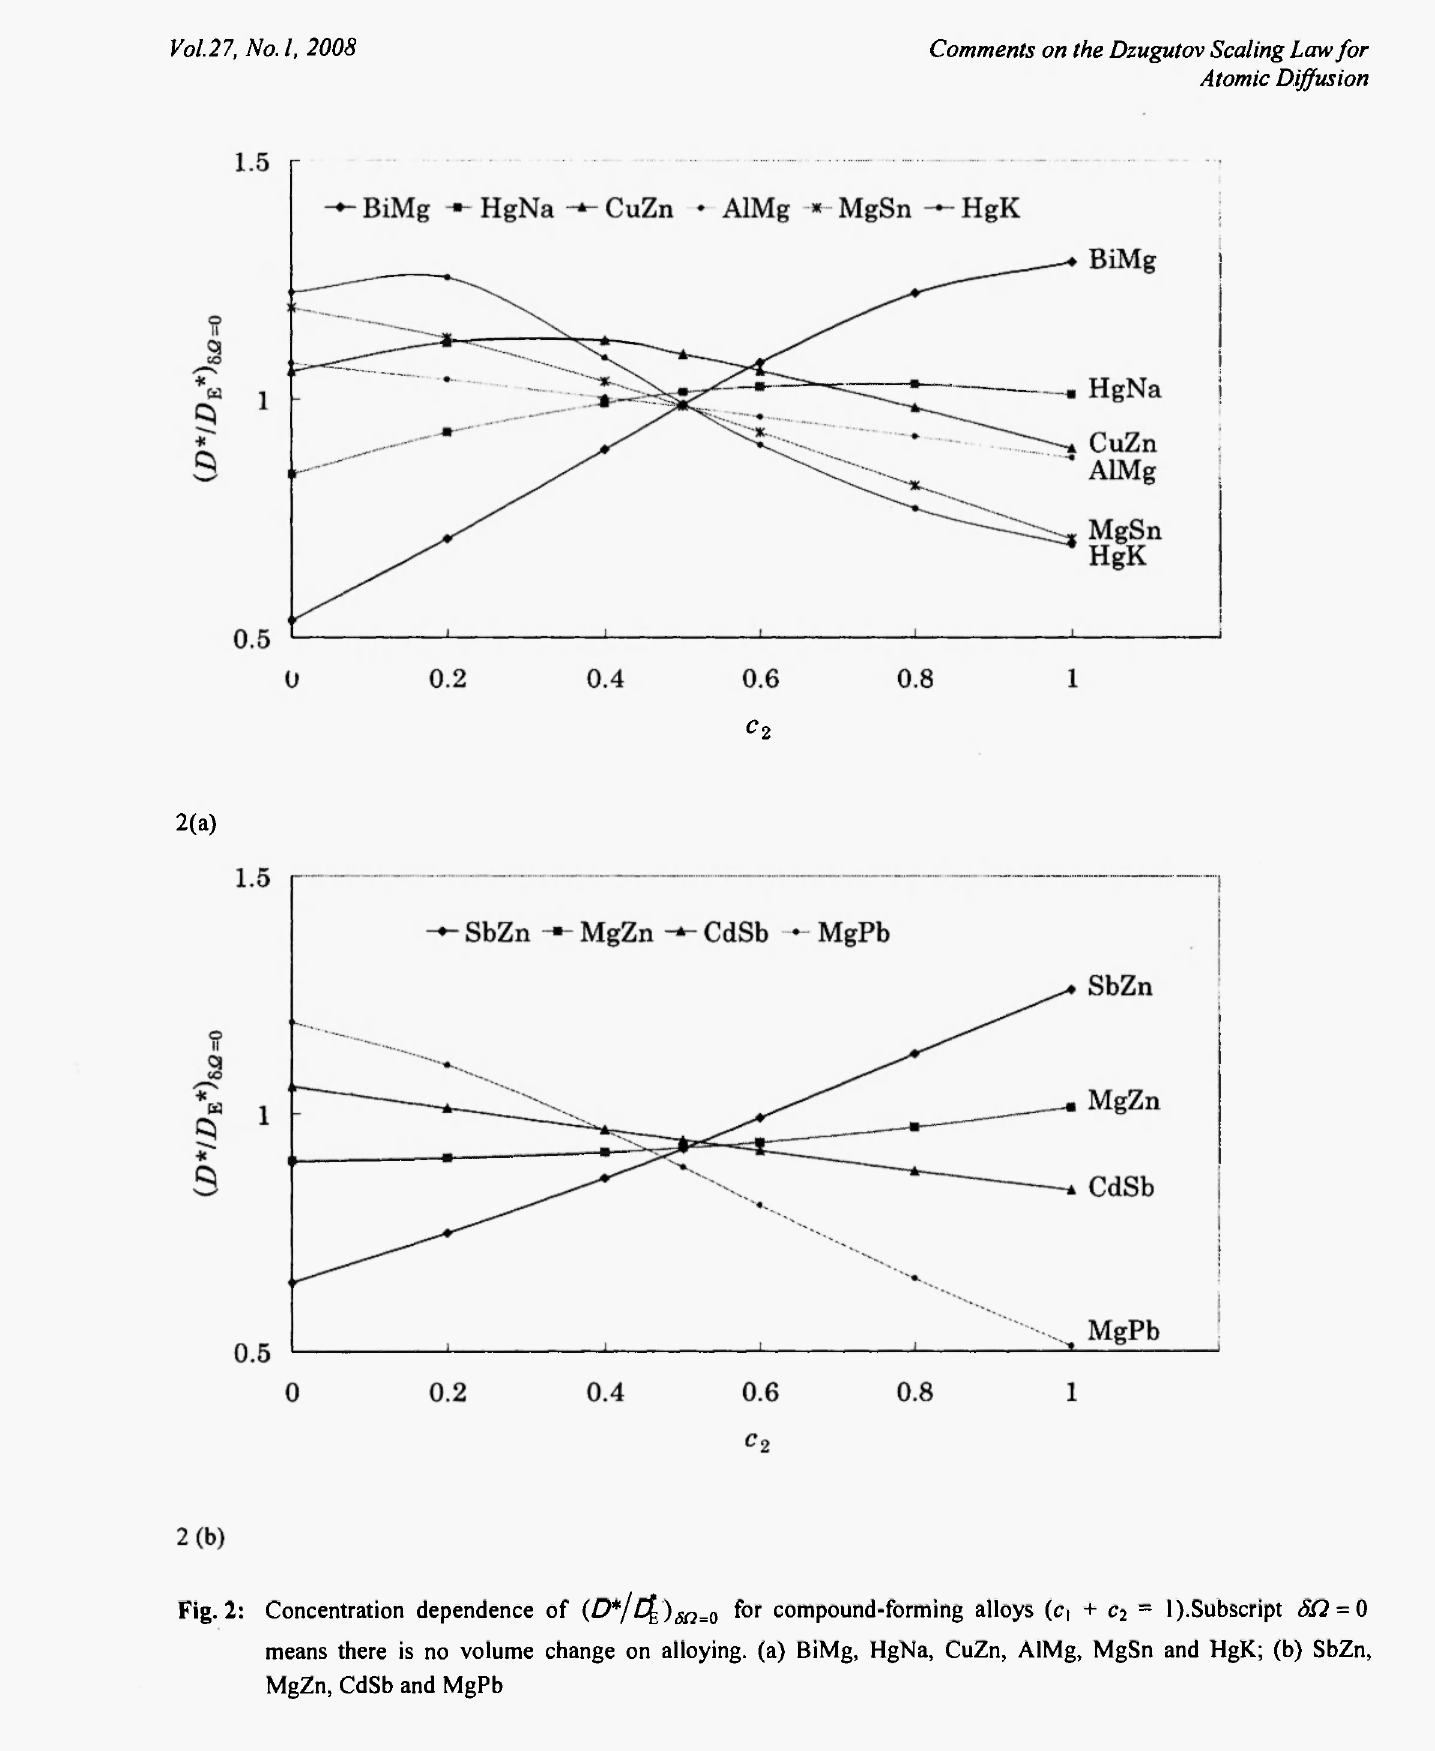
Fig. 2: Concentration dependence of {.D*/ 0 for compound-forming alloys (ci + c 2 = l).Subscript δΩ = 0 means there is no volume change on alloying, (a) BiMg, HgNa, CuZn, AlMg, MgSn and HgK; (b) SbZn, MgZn, CdSb and